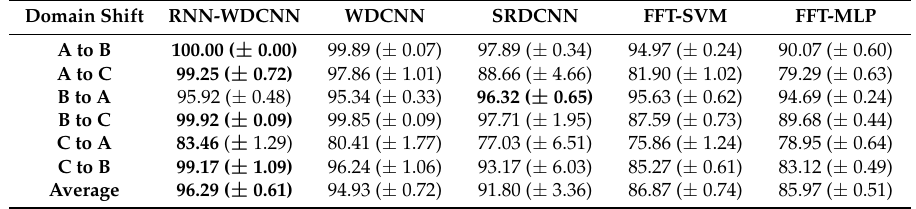
Figure 9. Confusion plots for the RNN-WDCNN model on the 6 different domain adaptation cases considered in scenario 1. Table 6. Precision scores of the models considered in this work (as a percentage) for the domain adaptation task considered in scenario 1 (best values are highlighted in